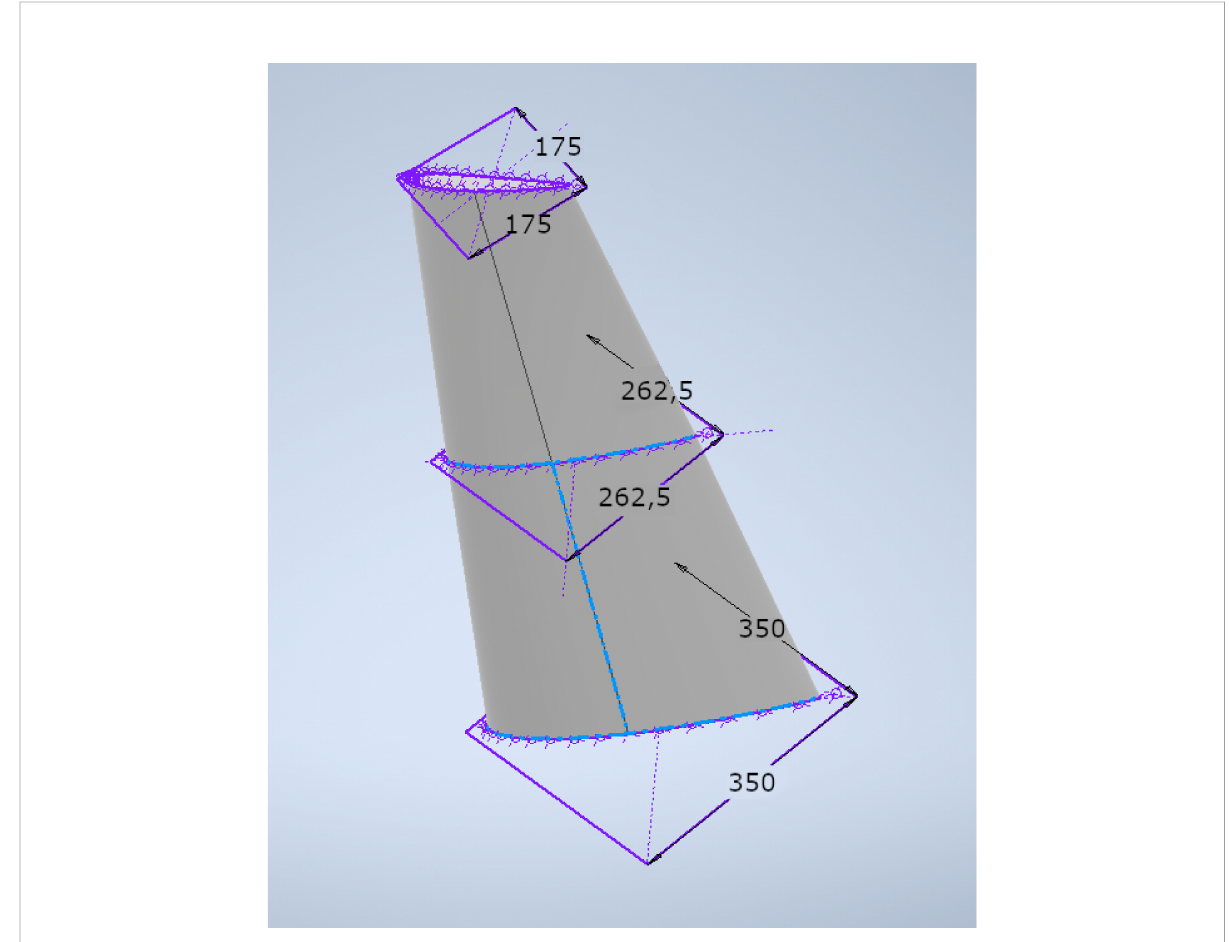
FIGURE 6 Final design depicted in a 3D simulation